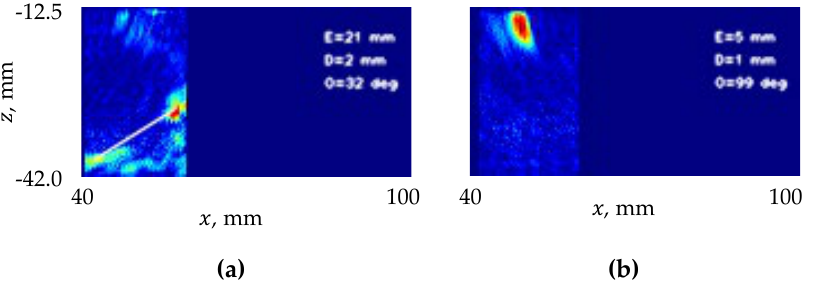
Figure 10. The DPS data set: the surface-breaking notch located 113 mm from the left edge, im- aged from the notched side. MTFM images have been obtained with ( a ) intensity threshold = 125, Dm = − 11, and ( b ) intensity threshold = 185, Dm = 15. Key as in Figure 7.